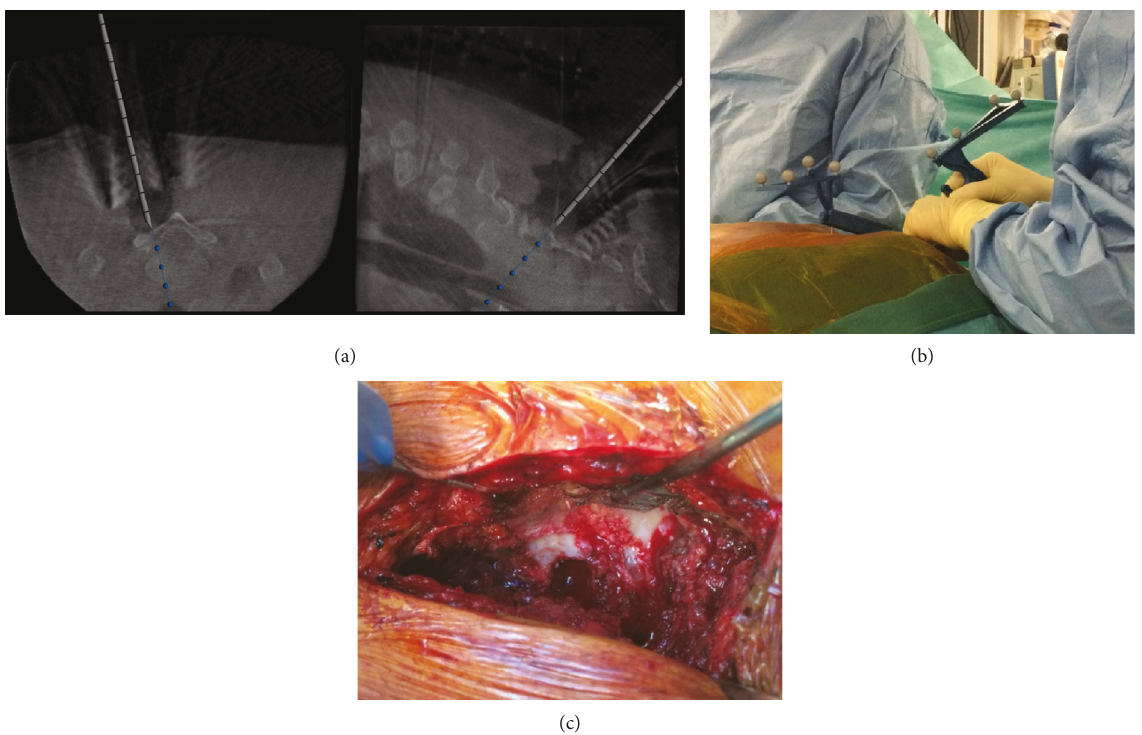
Figure 3: Intraoperative aspect. Navigation imaging (a). We can notice the nidus aspect close to the navigated trocar. The blue landmarks are separated 1 cm each. Reference frame and navigation trocar (b). Mini-open access, with the partial right laminectomy of the T1 vertebra (c) less than 1 cm square-sized. We can notice the pin inside the spinous process of the T1